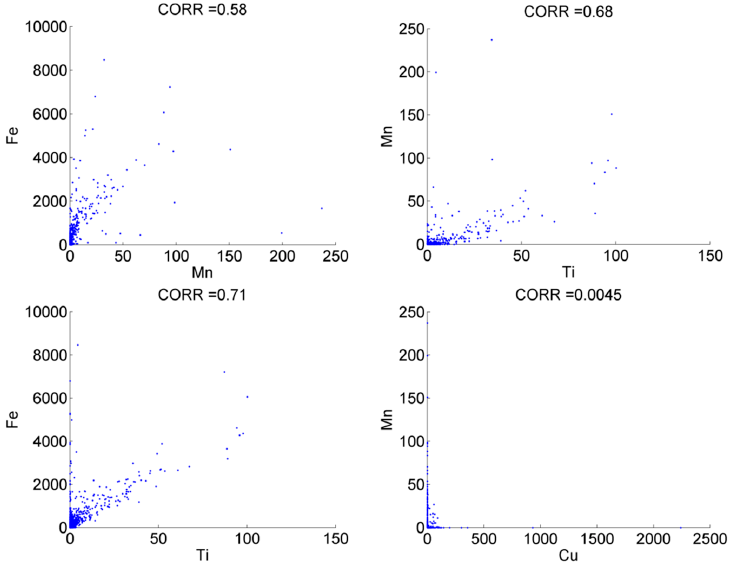
Figure 12. Correlations between characteristic X-ray intensities of Fe, Mn, Ti and Cu for monocentric agate.